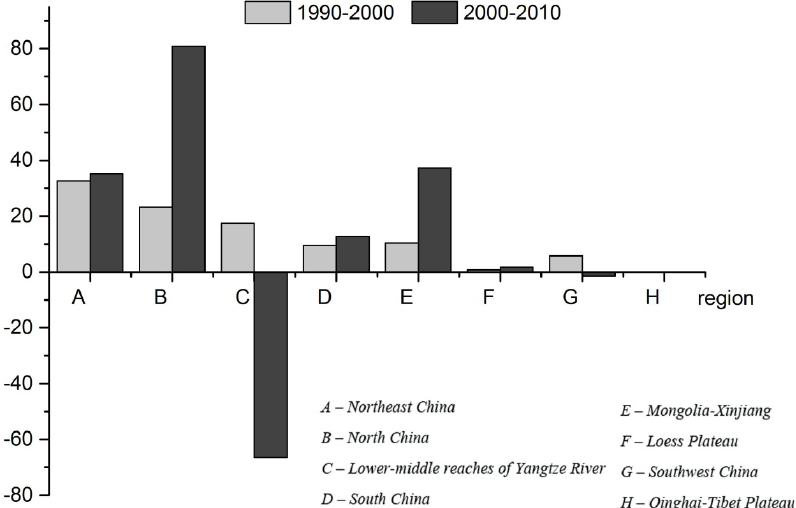
in various regions of E